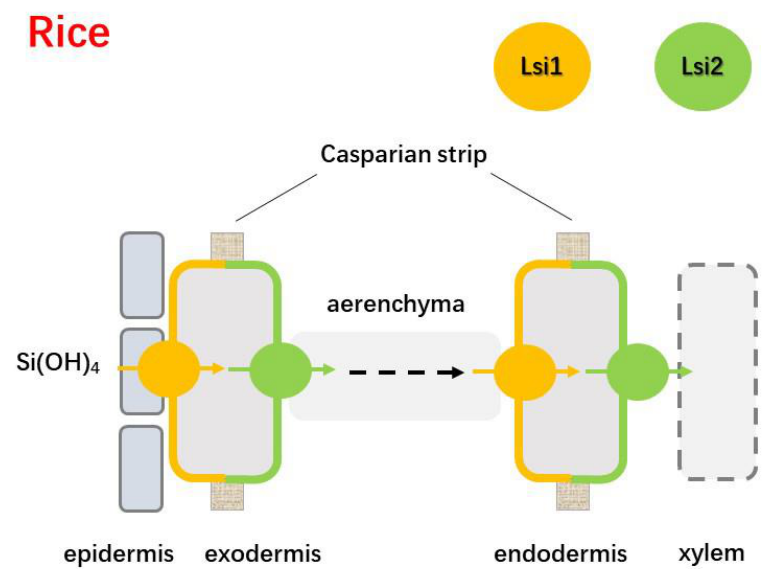
Figure 1. Schematic model of the Si transport system in rice.